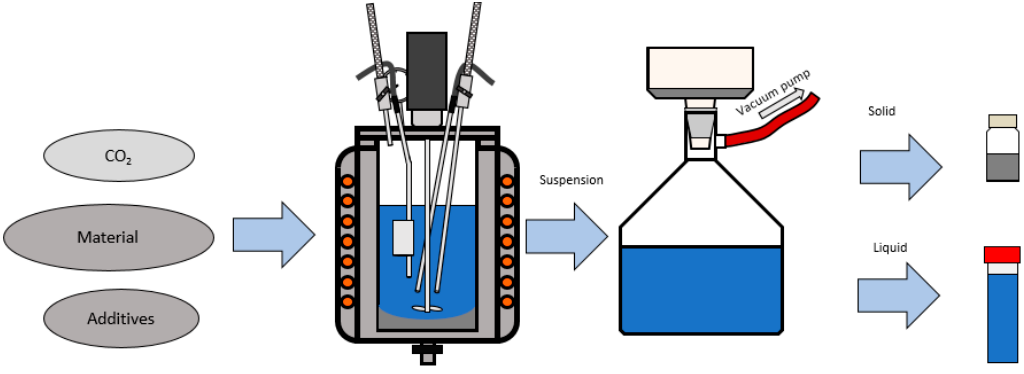
Figure 3. Carbonation process of olivine and a filtration with a sampling.